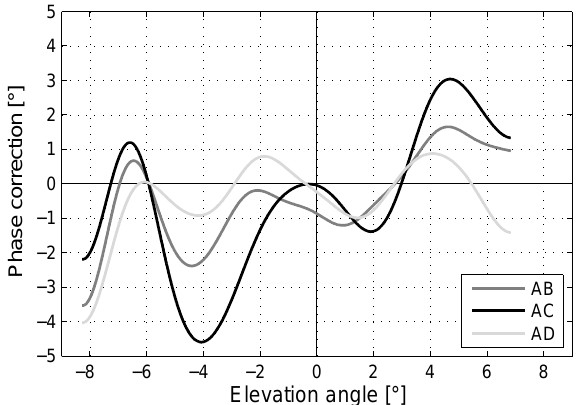
Figure 3. Relative elevation angle dependent phase correction curves for channels B, C and D. 0° corresponds to the beam center. Negative elevation angle values are below the beam center, while positive values are above the beam